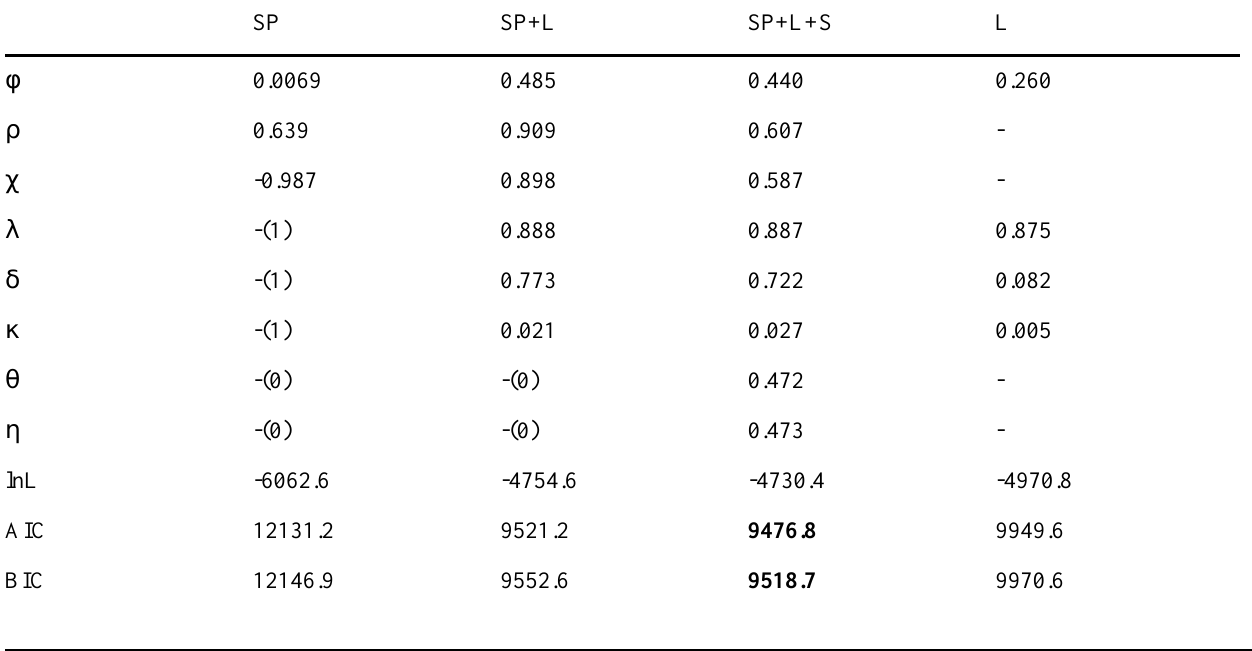
Table 4 . Estimated parameter values for different model versions using the data of experiments with 40 rounds and 60 rounds. The model versions are defined as follows: SP = probabilistic choice with social preferences, without learning and signaling; SP+L = probabilistic choice with social preferences with learning and without signaling; SP+L+S = probabilistic choice with social preferences with learning and with signaling; and L = probabilistic choice of income maximizers with learning and without signaling. See Table 2 for a list of parameters and their definitions. InL stands for maximum likelihood, AIC for Akaike Information Criterion, and BIC for Bayesian Information